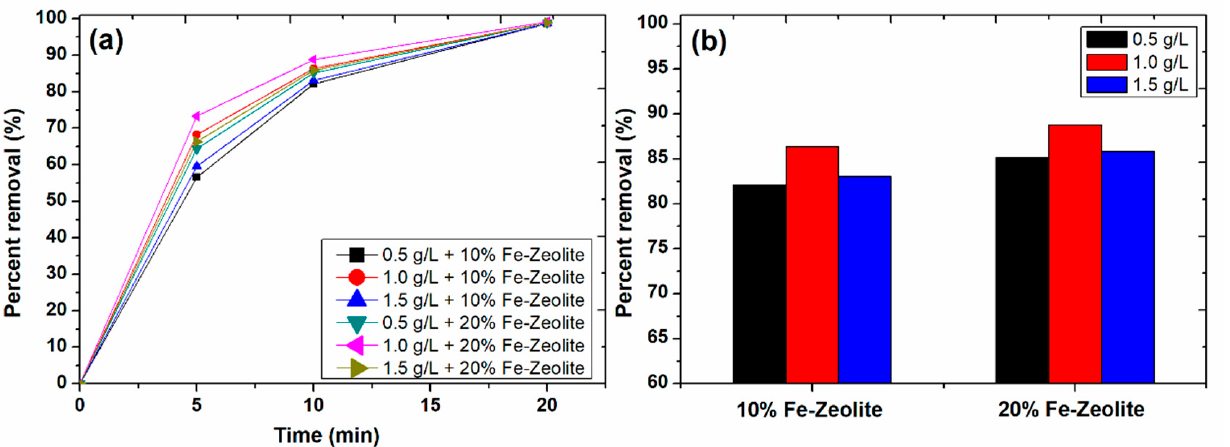
Figure 5. ( a ) Effect of catalyst dose and Fe-zeolite percentage on degradation of imidacloprid as a function of time, ( b ) percent degradation of imidacloprid using different catalyst doses and Fe-zeolite percentages at a time interval of 10 min.